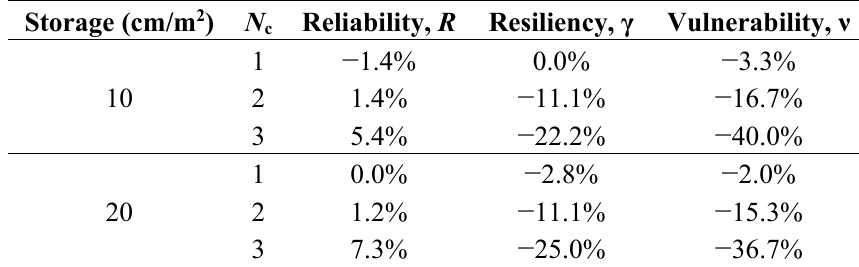
Figure 6. Vulnerabilities of four RBSNs under the historical rainfall (1970–1999) for the test catchments ( a ) 1001; ( b ) 1018; ( c ) 2022 and ( d ) 5001. Table 5. Percentage changes in the performance criteria for historical rainfall data (1970–1999) for